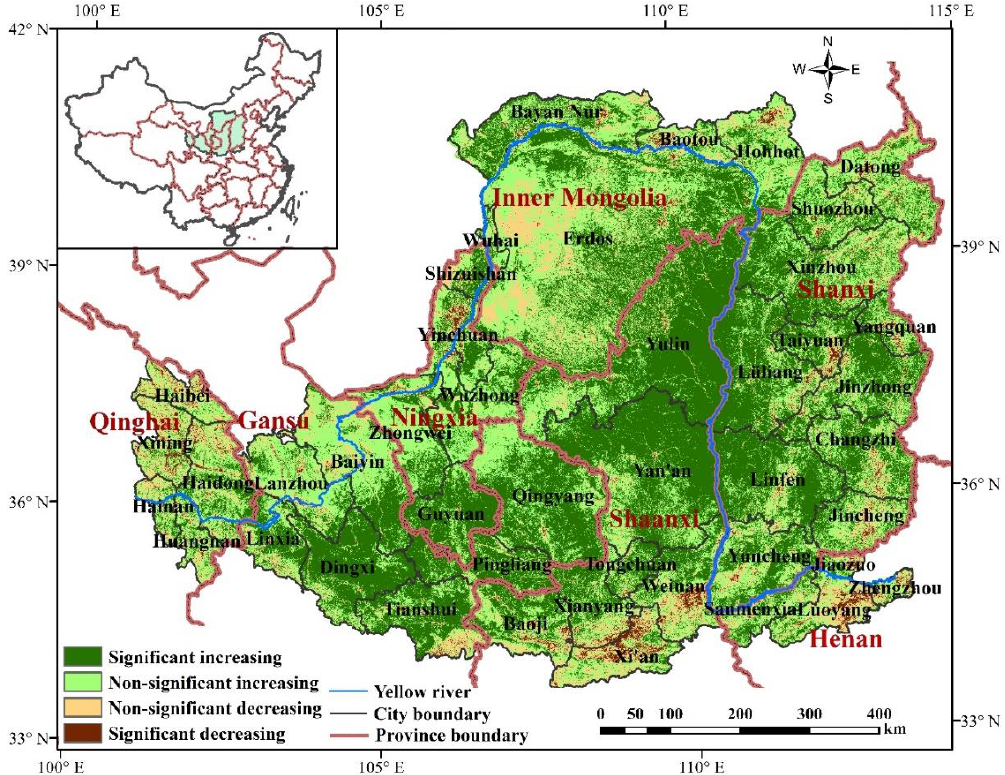
Figure 1. The location of the Loess Plateau, China, and a trend analysis (significant at p < 0.05 level) of vegetation coverage change from 2000 to 2015, using the Normalized Difference Vegetation Index (NDVI).